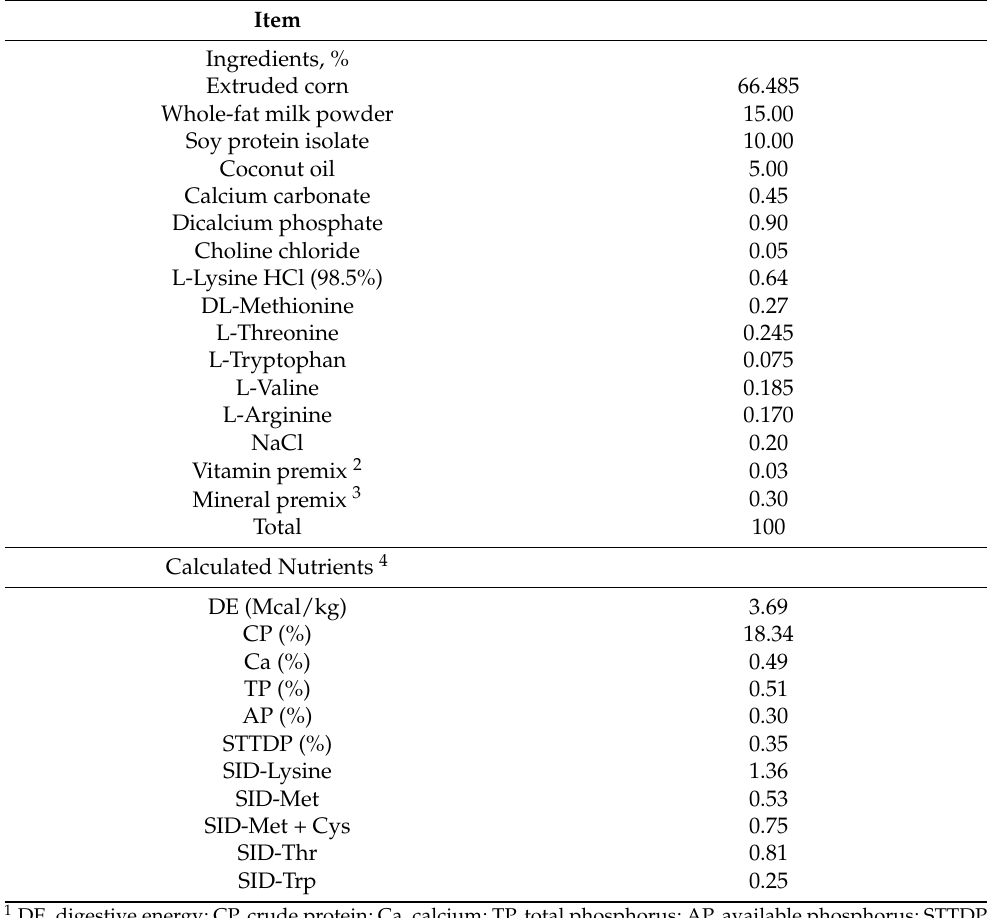
Table 1. Compositions and nutrient contents of the experiment basal diets 1 (air dry basis,